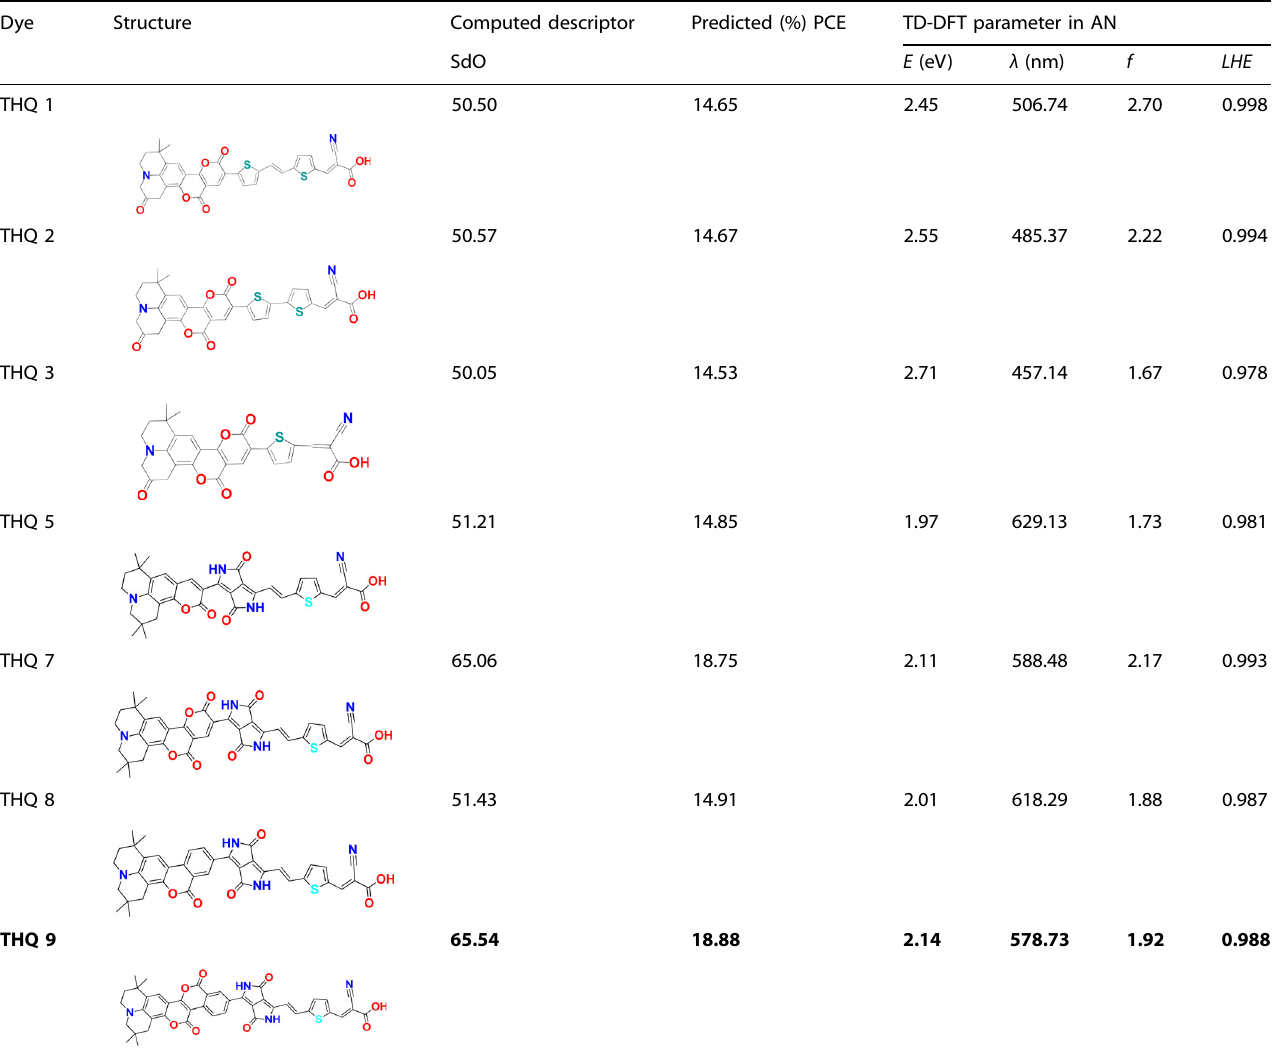
Table 2. Calculated descriptor, predicted %PCE and TD-DFT parameters [excitation energy ( E ), wavelength ( λ ), oscillator strengths ( f ), and light harvesting ef fi ciency (LHE) in acetonitrile (AN) media] of the designed Tetrahydroquinoline